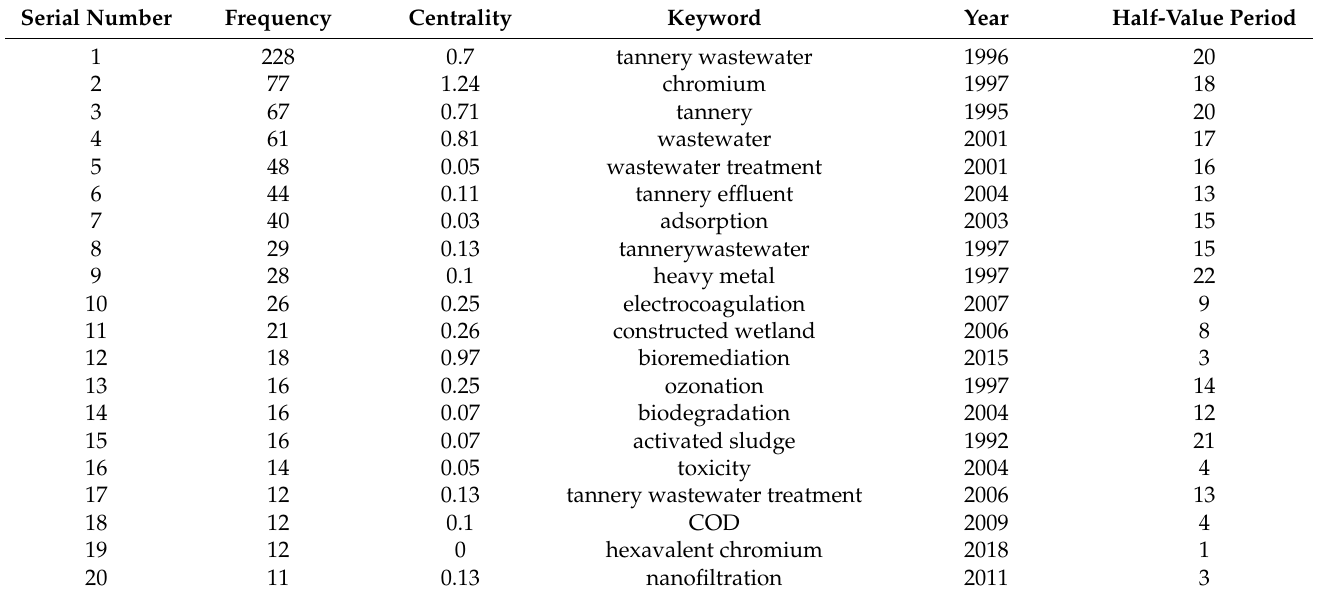
Table 5. Top 20 keywords in terms of frequency in tannery wastewater research. The greater the size of the node, the more frequently the keyword it represents appears in search results. The color of the node changes from chilly to warm as it moves from the center to the outside. The specifics of the top 20 high-frequency keywords in tannery wastewater studies are described in greater